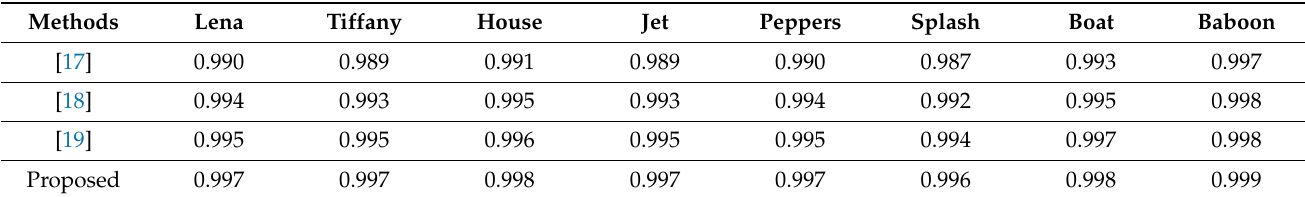
Table 5. SSIM comparisons with other works for α = 3.